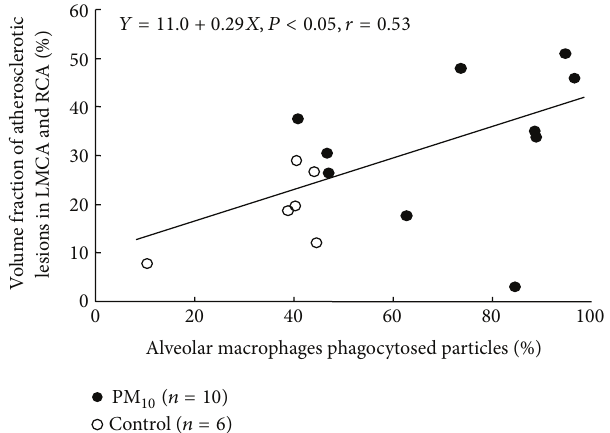
Figure 5: The correlation between the percentage of AMs that phagocytosed particles in the lung and the vol/vol (volume fraction) ofatheroscleroticlesions.ResultswerefromrabbitsexposedtoPM 10 for four weeks (solid circles; 𝑛 = 10 ) or saline (control; open circles; 𝑛 = 6 )